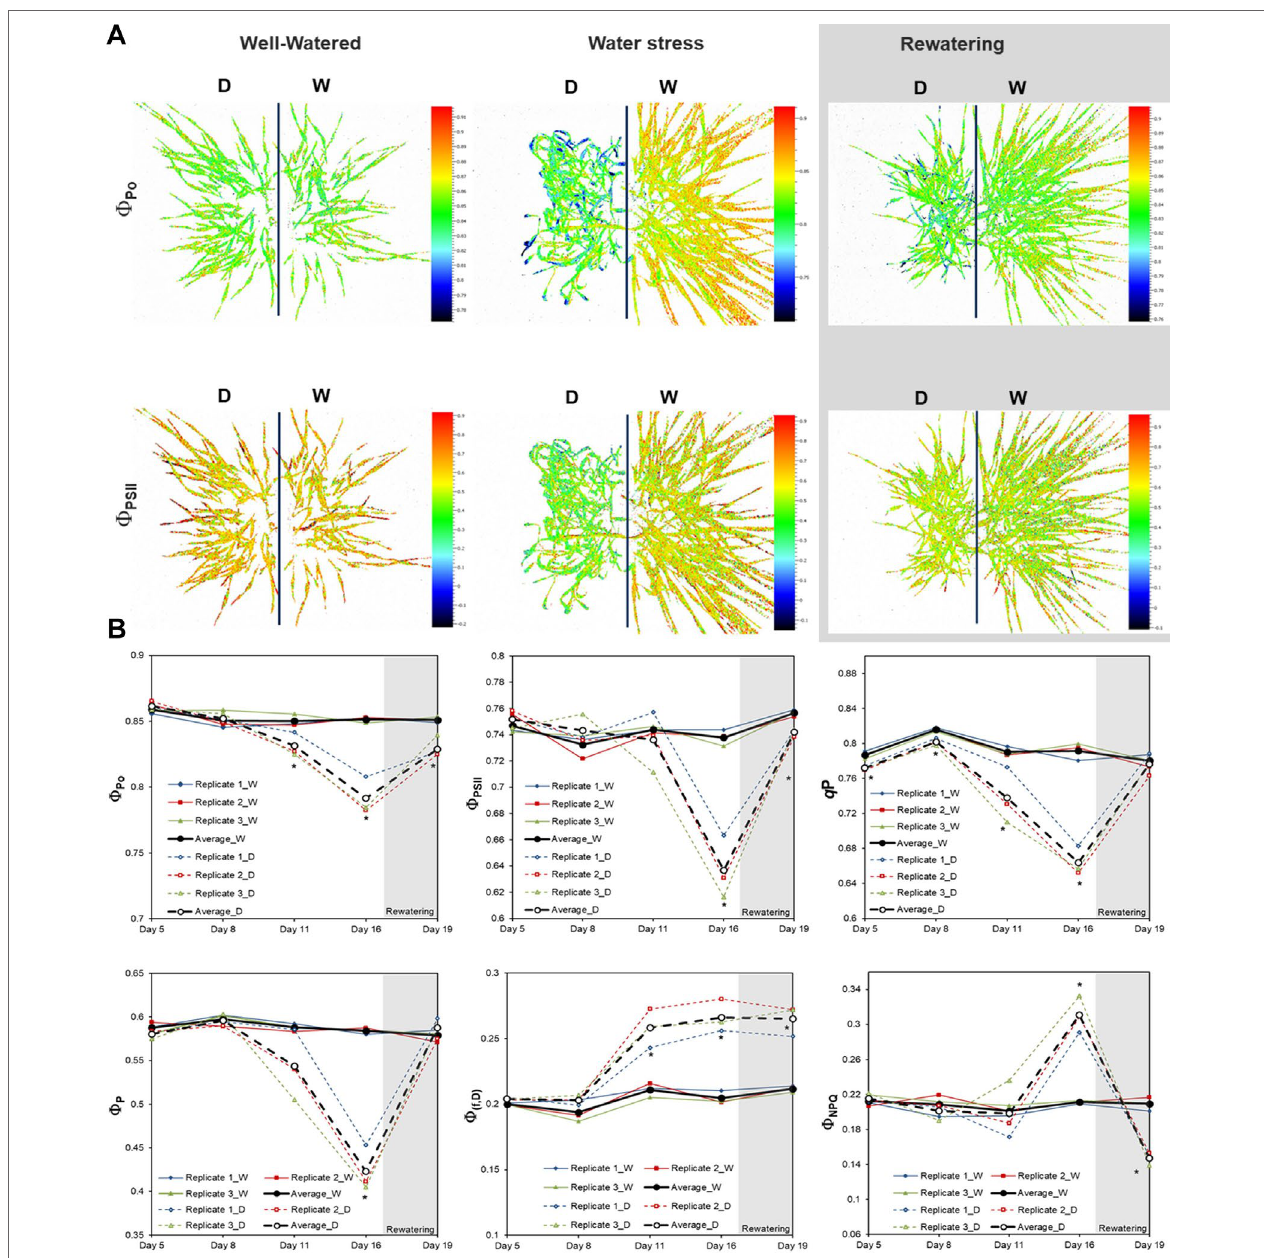
FIGURE 5 | Variation in chlorophyll parameters in barley ( Hordeum vulgare ) seedlings grown under water stress conditions and after subsequent rewatering. (A) Imaging of chlorophyll fluorescence ( Φ Po and Φ PSII ) in barley seedlings under well-water, water stress, and rewatering. Stressed and non-stressed plants labeled as D (left) and W (right), respectively. (B) Chlorophyll fluorescence parameters from three independent trays (Barley 1, 2, and 3) (n = 50) and the average values. D and W variants are represented by discontinuous and continuous lines, respectively. Statistical analyses were performed via ANOVA. Asterisks indicate the significance level relative to the control variant; * P ≤